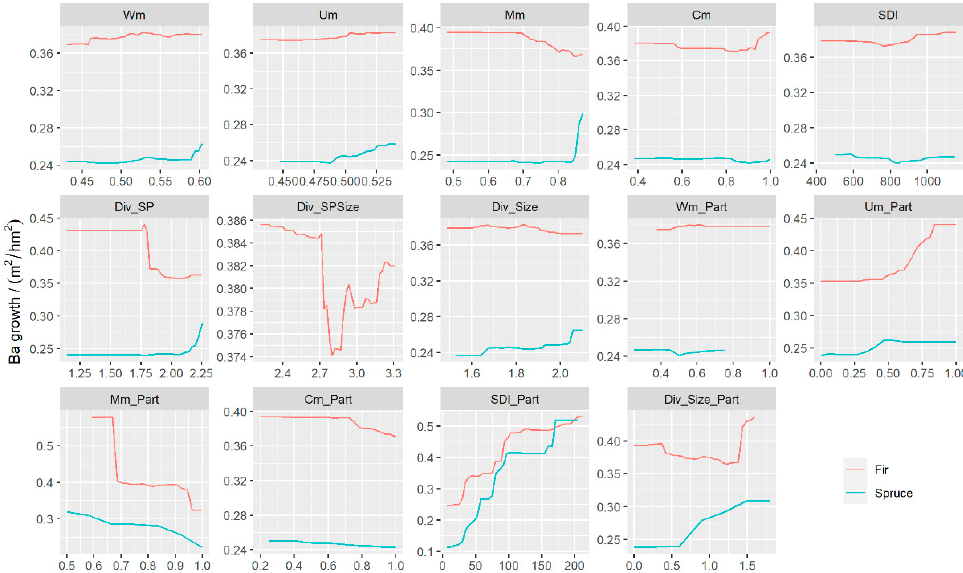
Figure 4. Basal area increment (BAI) of tree species simulations in relation to the most-important predictor variables.